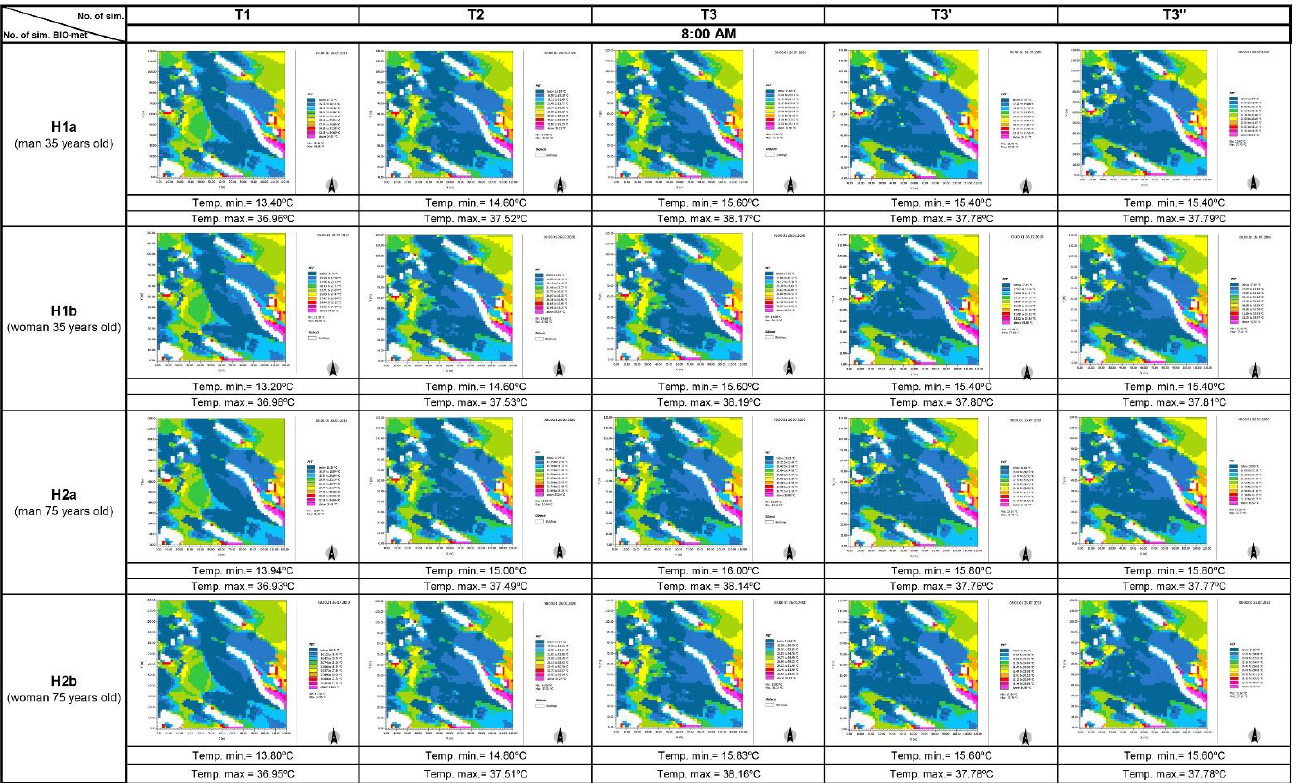
Figure 11. Summary of simulations for each group at 8:00 am .